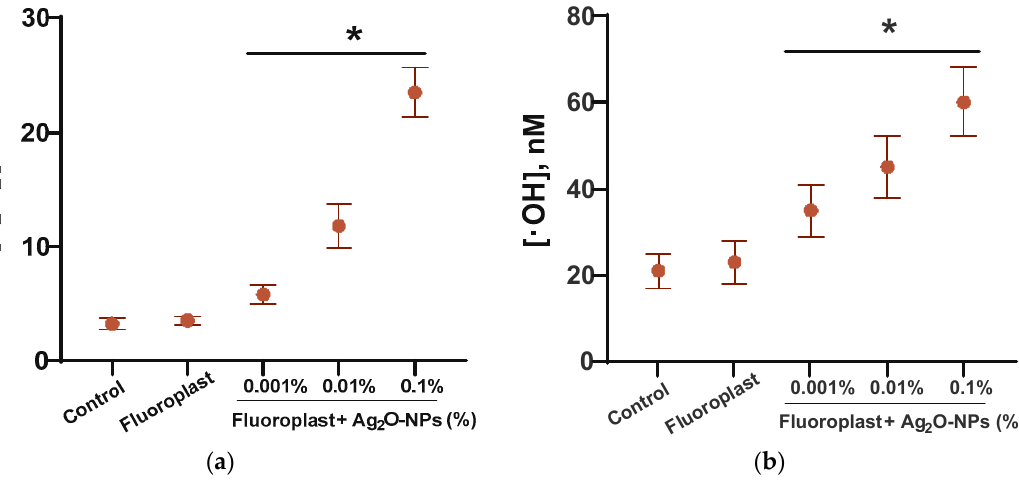
Figure 5. ROS generation in the presence of fluoroplast/Ag 2 O NPs composite coating: ( a ) generation of hydrogen peroxide (2 h, 40 °C); ( b ) generation of hydroxyl radicals (2 h, 80 °C). Data are presented as Mean ± SE. * p < 0.05, Mann–Whitney test ( n = 3).